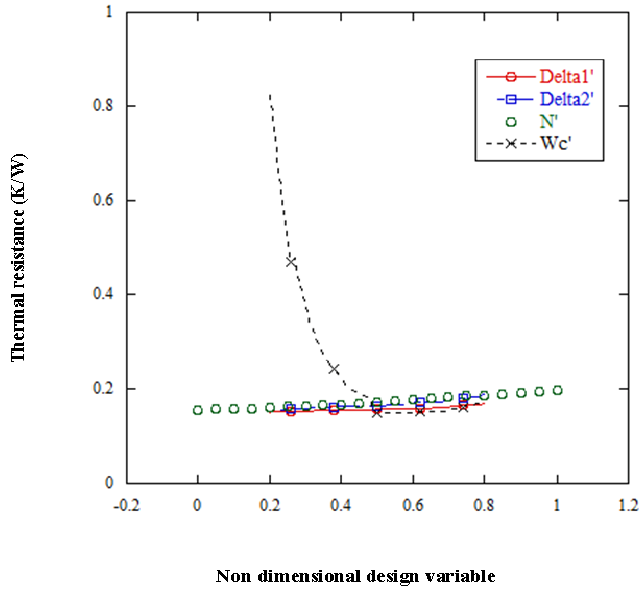
Figure 6. Sensitivity analyses of the non-dimensional design variables for the micro channel heat sink (initial W c = 50%W p )